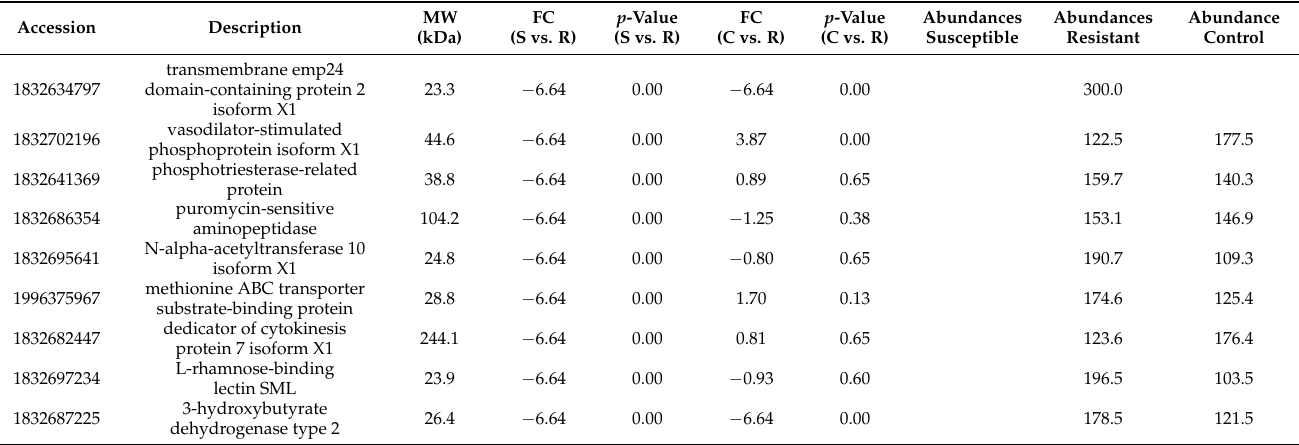
Table 6. Potential biomarker